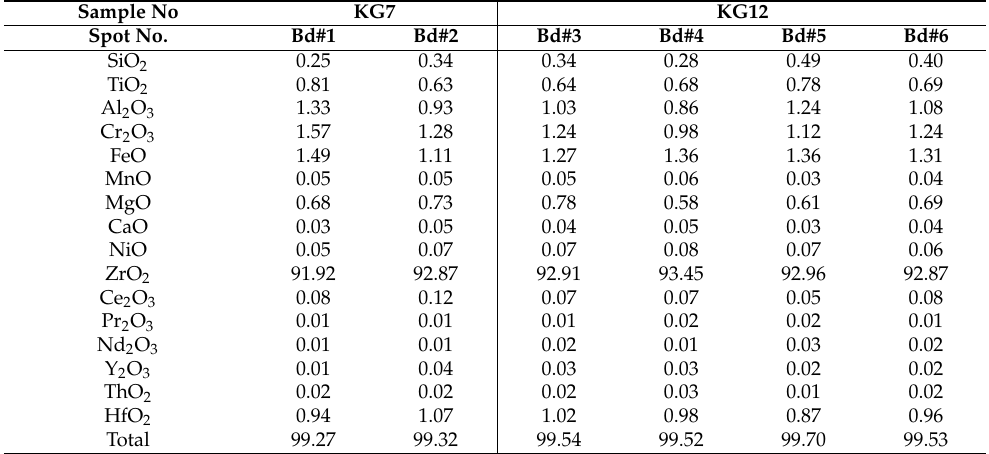
Table 7. Microprobe analyses of baddeleyite in the olivine gabbro of the Khamal mafic intrusion. Sample No KG7 KG12 Spot